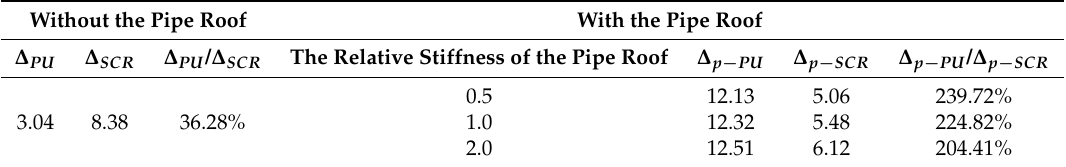
Table 4. Comparison of the excavation face displacement corresponding to limit support pressure and surface critical settlement,